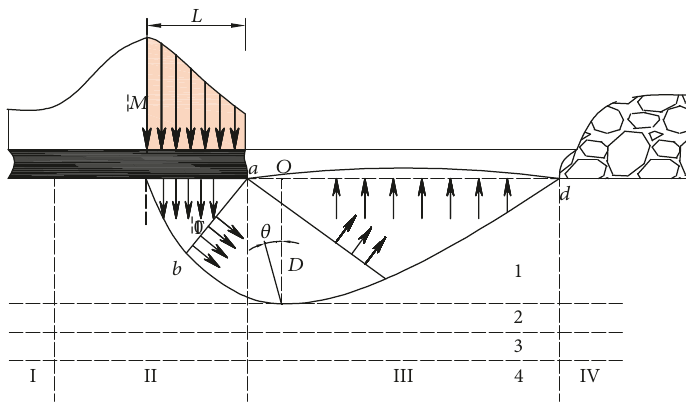
Figure 3: Floor failure depth caused by the bearing